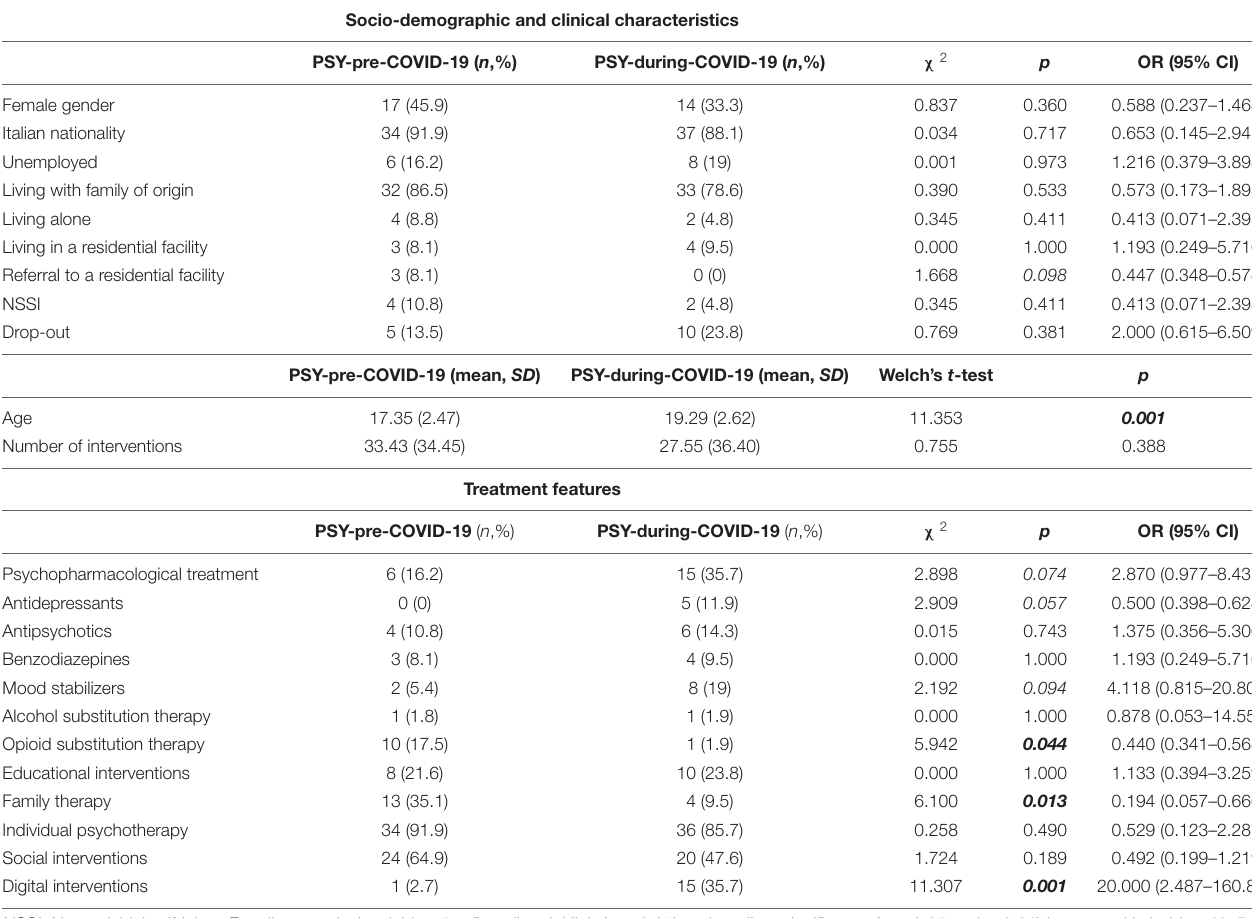
TABLE 2 | Comparison of socio-demographic and clinical characteristics of subjects accessing the service before (PSY-pre-COVID-19; n = 37, 46.8%) and after the COVID-19 pandemic outbreak (PSY-during-COVID-19; n = 42, 53.2%). Socio-demographic and clinical